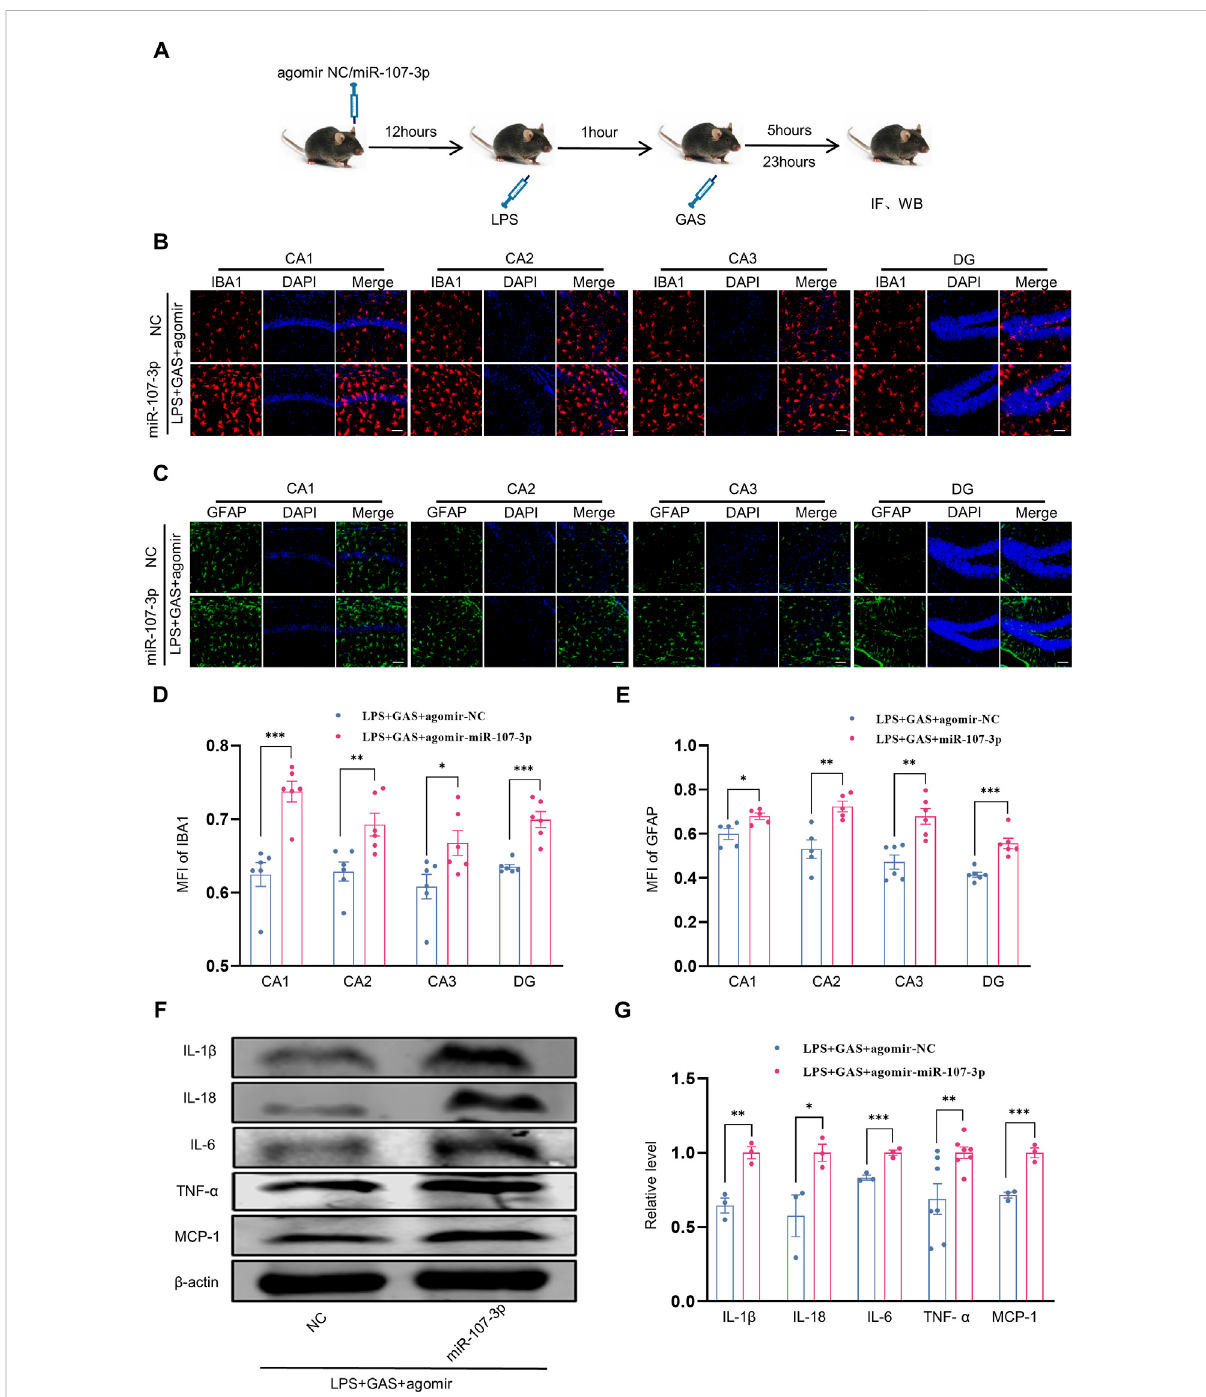
FIGURE 5 Effects of miR-107-3p on GAS inhibiting the LPS-induced neuroin fl ammation. (A) Flow chart of miR-107-3p agomir injection on the neuroin fl ammation in mice. (B – E) representative images of IF staining and histograms of MFI for GFAP-positive astrocyte (green), and IBA1-positive microglia (red) in the CA1, CA2, CA3, and DG regions of hippocampus. Scale bar = 30 μ m. (F,G) Representative protein bands and the histograms of bands intensity analysis of IL-1 β , IL-18, IL-6, TNF- α , and MCP-1 in the hippocampus. Values are represented as means ± SEM for three mice in eachgroup.*** p < 0.001,** p < 0.01,* p < 0.05versusLPS+GAS+agomirNCgroup.LPS,lipopolysaccharide;GAS,gastrodin;IL-1 β ,Interleukin-1;IL- 6,Interleukin-6;IL-18,Interleukin-18;Tumornecrosisfactor- α ,TNF- α ;MCP-1,MonocyteChemoattractantProtein-1;IF,Immuno fl uorescence;WB, western blot; MFI, the mean fl uorescence